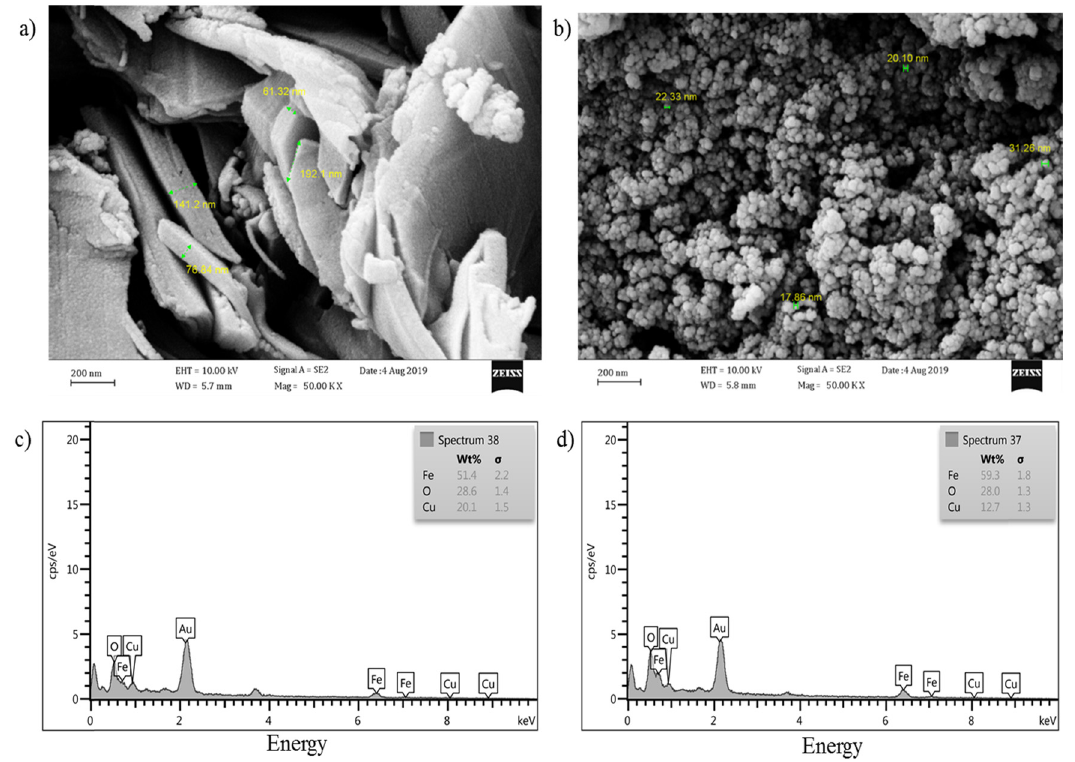
Figure 2: FE - SEM – EDS images of NPs: FE - SEM of NPs calcined at 500°C for 4 h ( a ) , 8 h ( b ) , and EDS of CFN ( c and d ) .